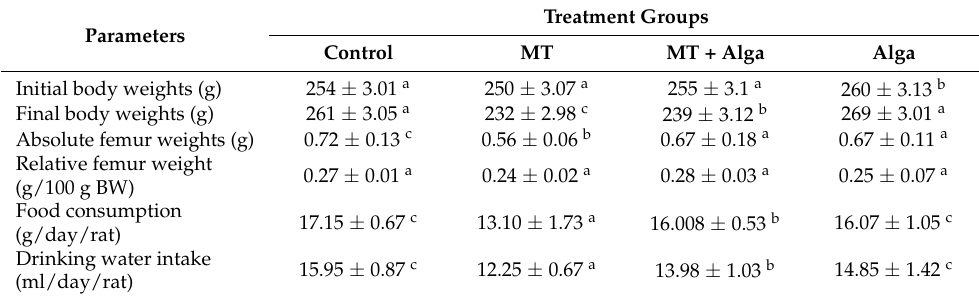
Table 2. Initial and final body weights, absolute and relative femur weights, daily food and water consumption by control and treated rats with MT and MT co-administrated with FRE for 7 days.